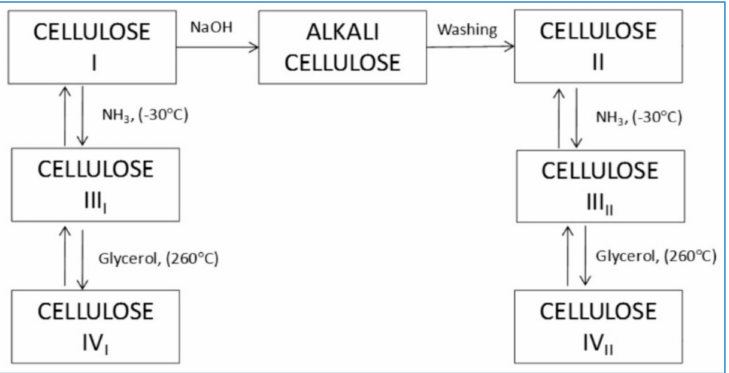
Figure 2. Schematic representation of preparation of different allomorphic forms of